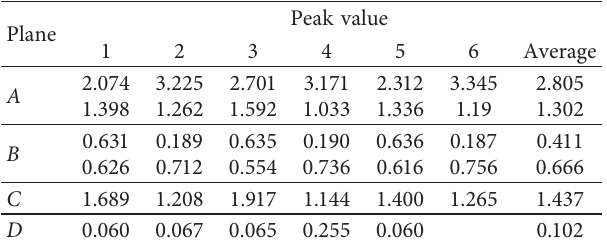
Table 4: Peak values of points at 0rad/s, and the unit is